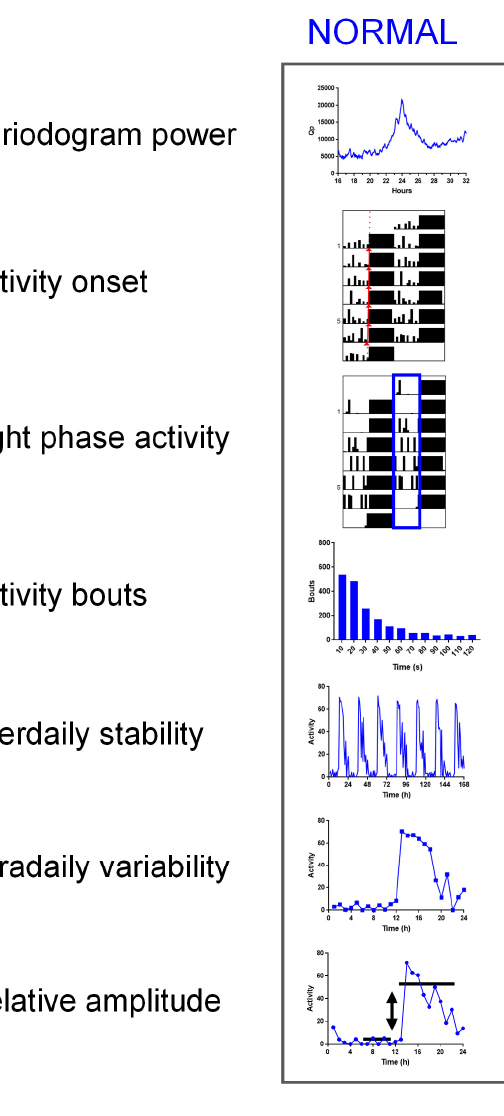
Figure 2. Commonly used measures of circadian disruption. Images of each parameter are shown for normal healthy animals (blue), along with representative changes that would be expected with circadian disruption (red). See text for details. Table 1. Normal ranges of circadian parameters in